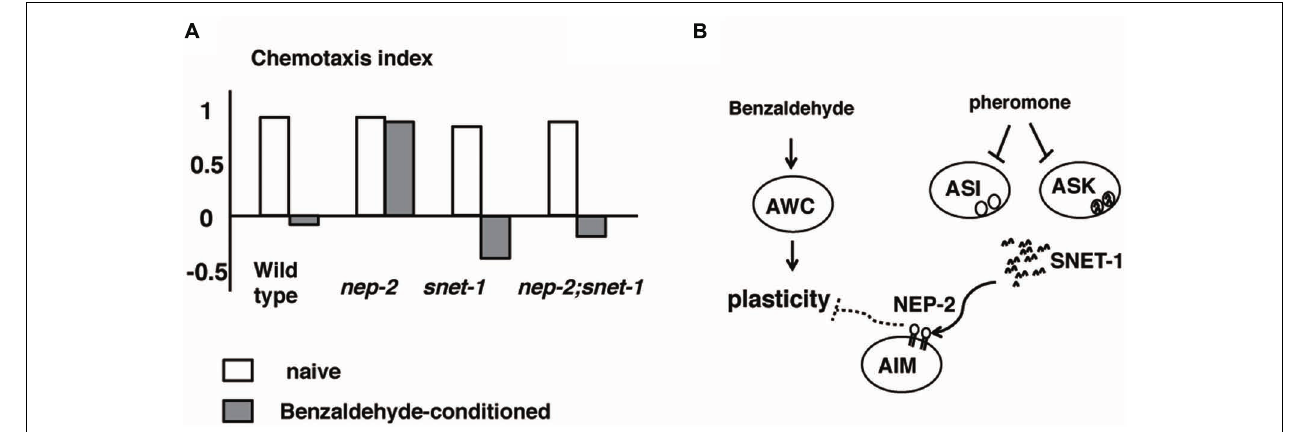
FIGURE 6 |Alteration to odorant preference influenced by population density of animals (Yamada etal., 2010). (A) Olfactory plasticity of nep-2 , snet-1 , nep-2:snet-1 mutants. The nep-2 mutants exhibited defective olfactory plasticity. The abnormality olfactory plasticity of nep-2 mutants is suppressed by the mutation in the snet-1 gene. (B) . Proposed model of the alteration of olfactory plasticity induced by crude pheromone. SNET-1 is a